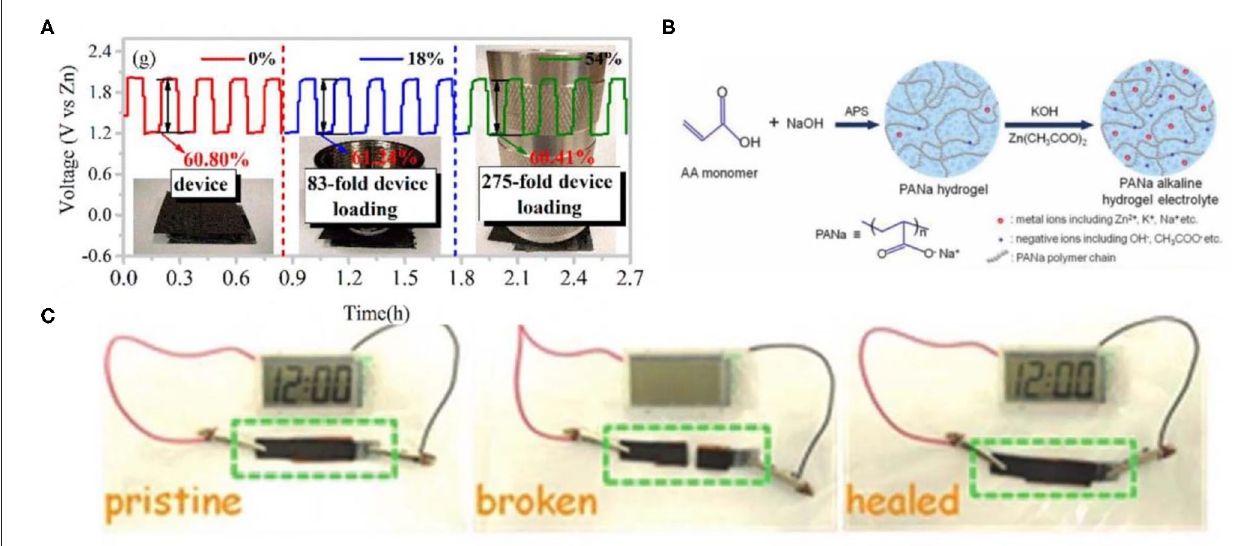
FIGURE 4 | (A) Galvanostatic discharge-charge cycling curves at a current density of 5mA cm − 2 . Reprinted with permission from Ma et al. (2018a). Copyright (2018) American Chemical Society. (B) Synthesis of the PANa hydrogel electrolyte. Reprinted with permission from Huang et al. (2018a). Copyright (2018) John Wiley and Sons. (C) Photographs of the self-healing aqueous battery powering a clock before cutting (left), after cutting (middle), and after self-healing (right). Reprinted with permission from Huang et al. (2018b). Copyright (2018) John Wiley and